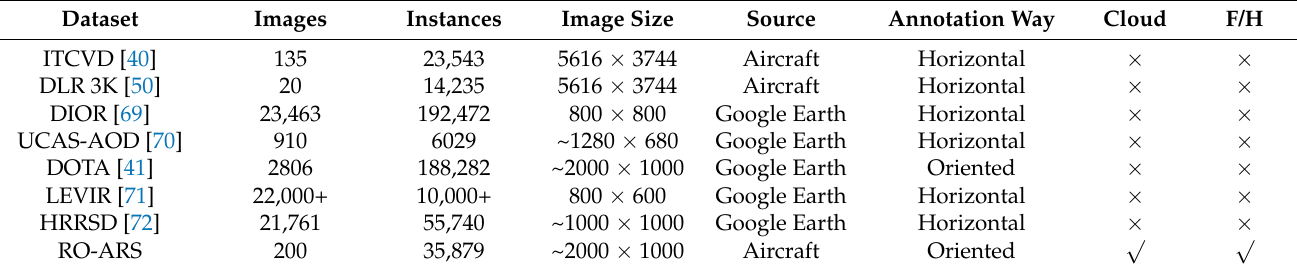
Table 2. Comparison of different optical remote sensing